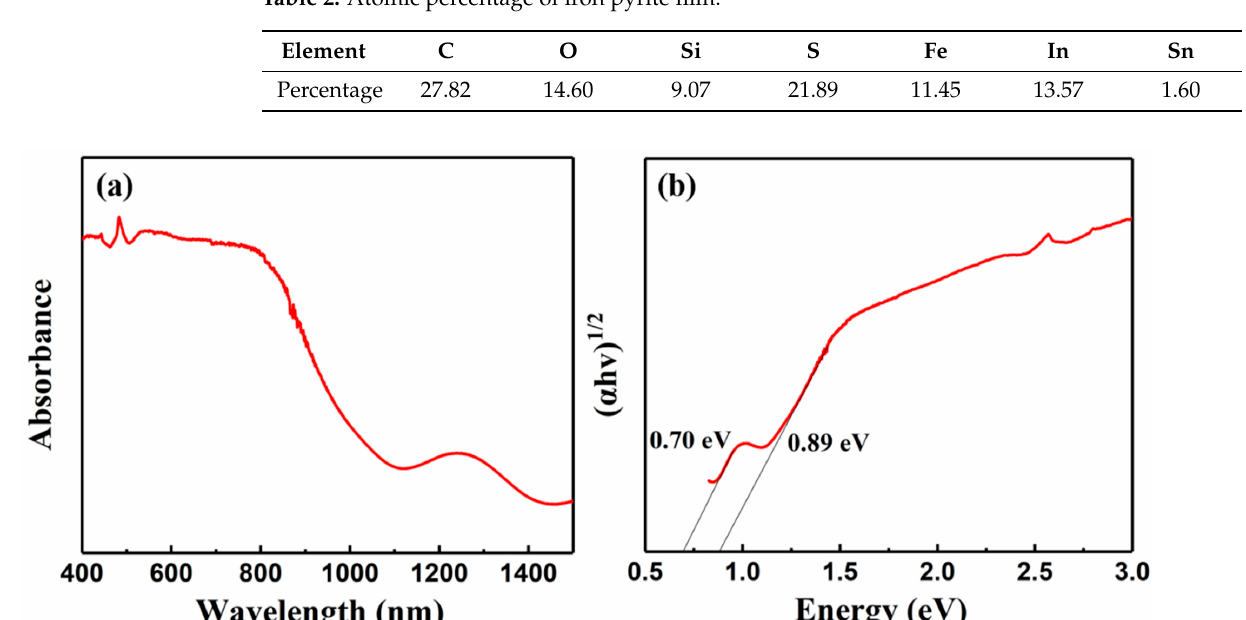
Figure 8. ( a ) Absorption spectrum and ( b ) Tauc plot of the iron pyrite film. The surface morphologies of the precursor film and iron pyrite film are shown in Figure 9a,b, respectively. The precursor film is not very continuous, with characteristics of two different phases. After sulfurization, the surface morphology of the film changes obviously, and the film becomes even and continuous. The cross section of the film is shown in Figure 9c. The iron pyrite film is flat and dense. The surface morphology of the film is comparable to that prepared by spin coating [15,29].